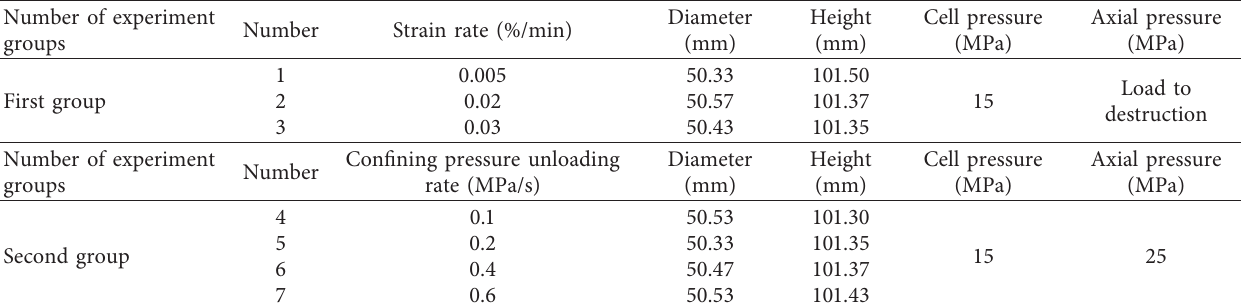
Figure 3: Coal samples. (a) No. 1 coal sample. (b) No. 2 coal sample. (c) No. 3 coal sample. (d) No. 4 coal sample. (e) No. 5 coal sample. (f) No. 6 coal sample. (g) No. 7 coal sample. Table 1: Parameters of coal